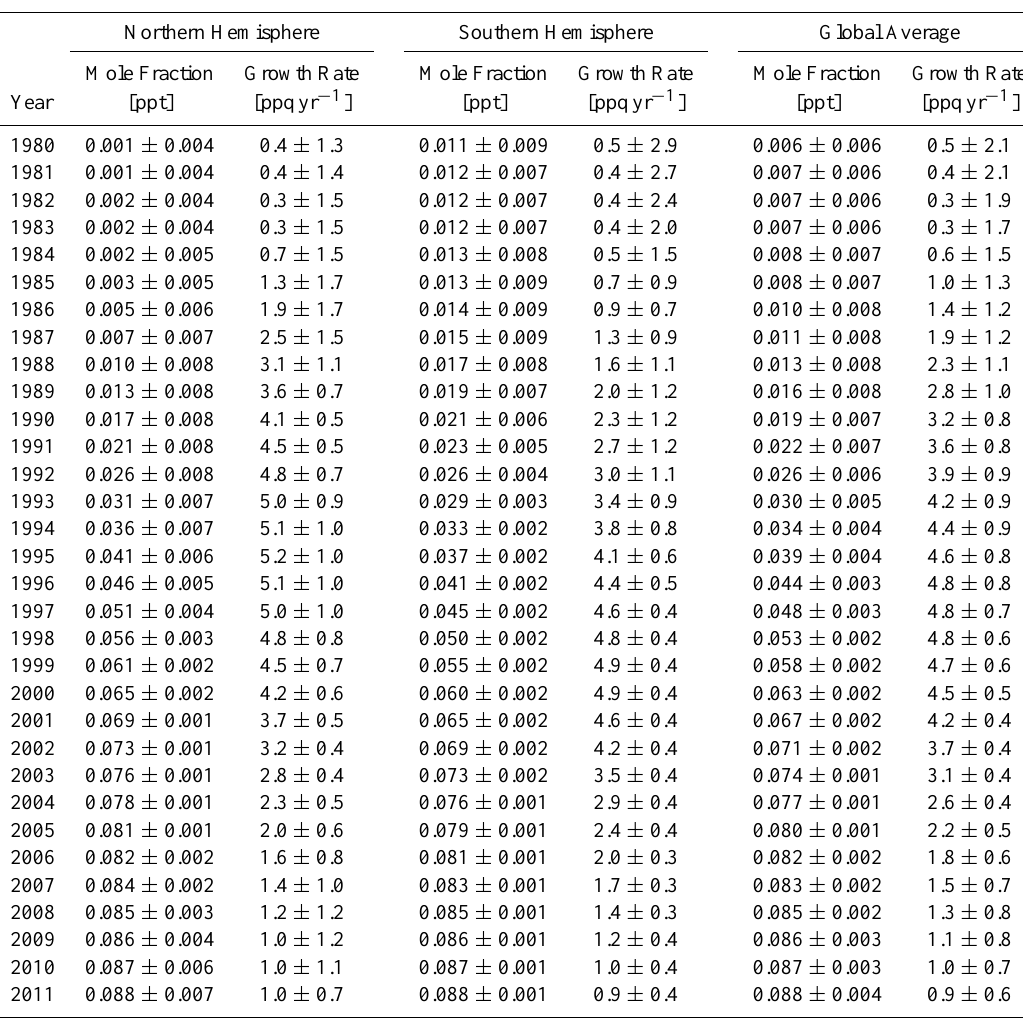
Table 7. Northern and Southern Hemisphere and Global Average Annual Mean Mole Fractions and Growth Rates and Associated Uncer- tainties 1980–2011 for C 8 F 18 .